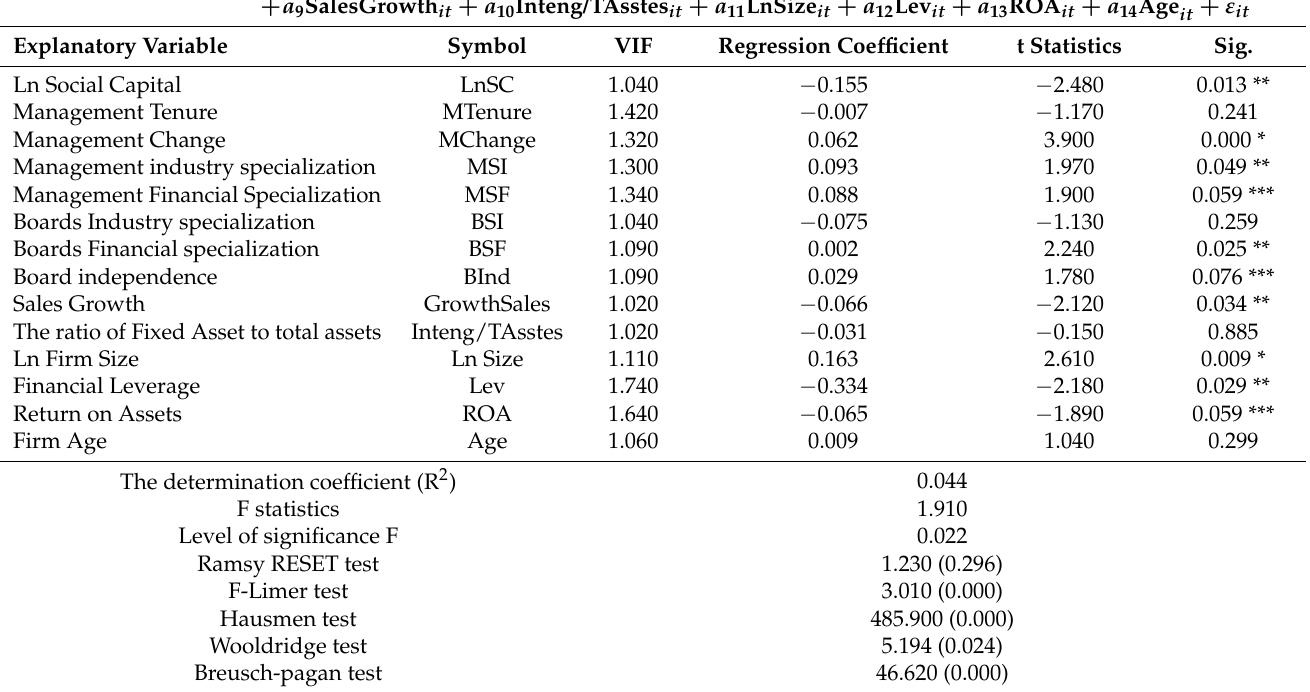
Table 7. The Results of testing the third hypothesis